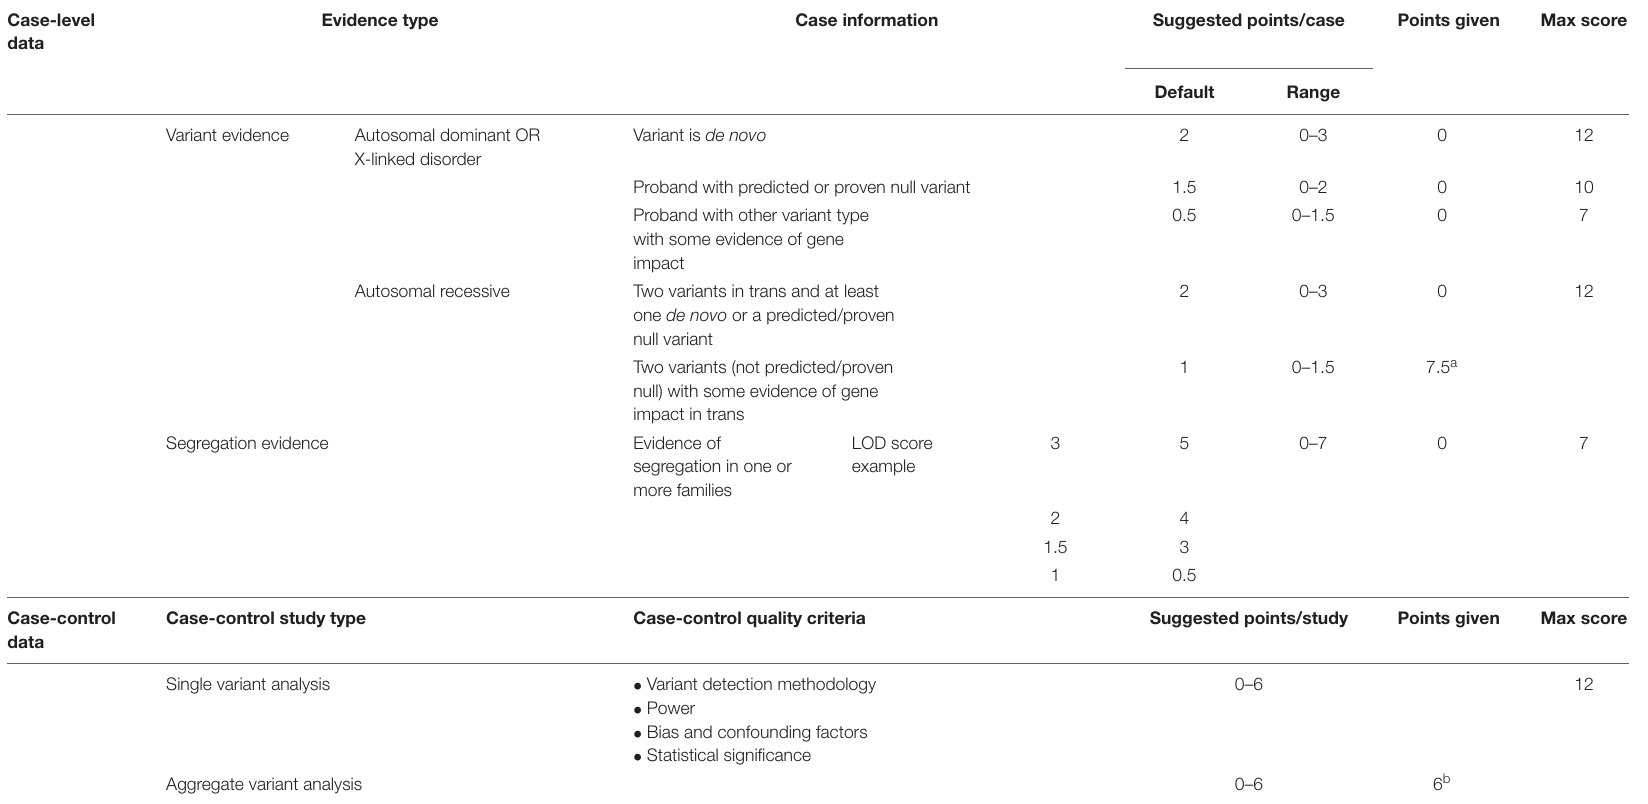
TABLE 3 | Evaluating the clinical validity of PKD1 -epilepsy associations based on the framework developed by the clinical genome resource. Case-level